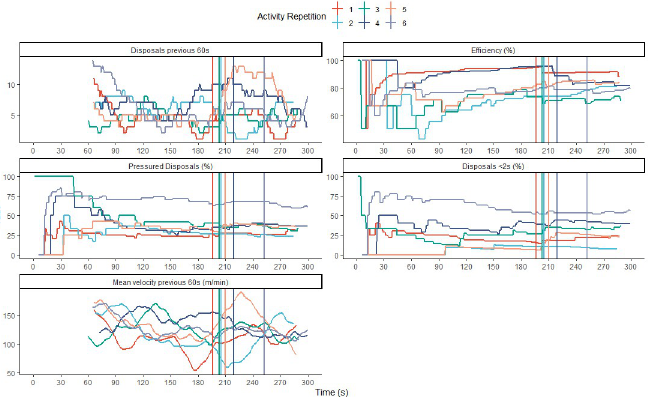
Fig 5. The sequences and multivariate changepoint locations for each feature of six activity repetitions. The feature value through the duration of the activity is displayed with straight vertical lines indicating a change point location. For velocity, the rolling mean over the previous 60 s is displayed to improve its visual interpretability. Feature sequences and changepoint locations are coloured according to activity